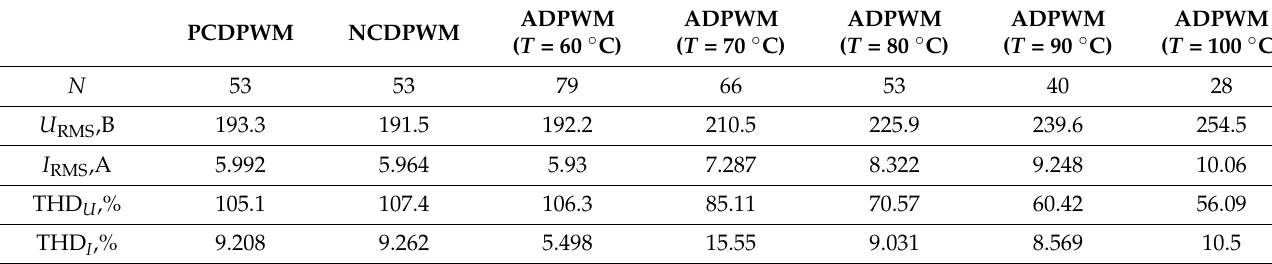
Table 3. Simulation results at MI = 0.6.